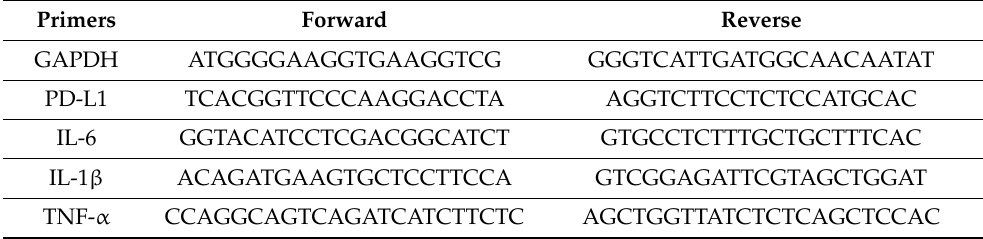
Table 1. List of primers used for Real-Time